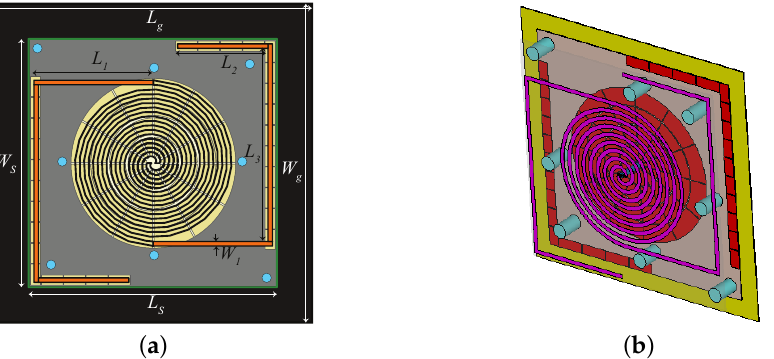
Figure 6. Antenna with suspended HIS and 3D printed posts: ( a ) front view; ( b ) perspective view (with transparent antenna substrate for ease of visualization). (Iteration 2 design).